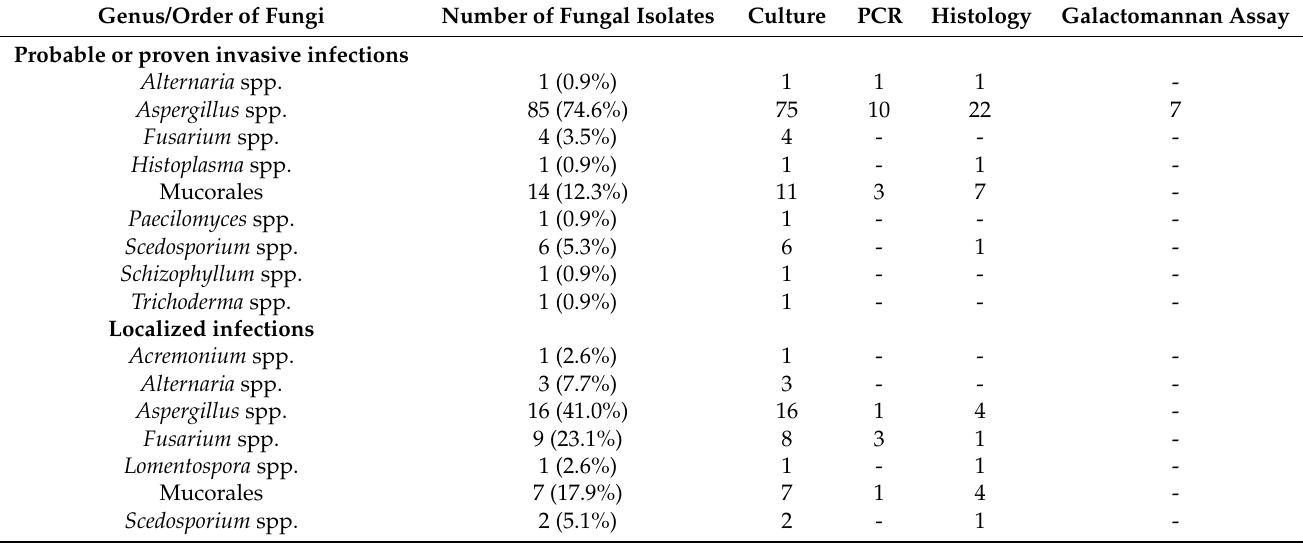
Table 5. Diagnostics methods by genera for probable or proven invasive and localized infections. Genus/Order of Fungi Number of Fungal Isolates Culture